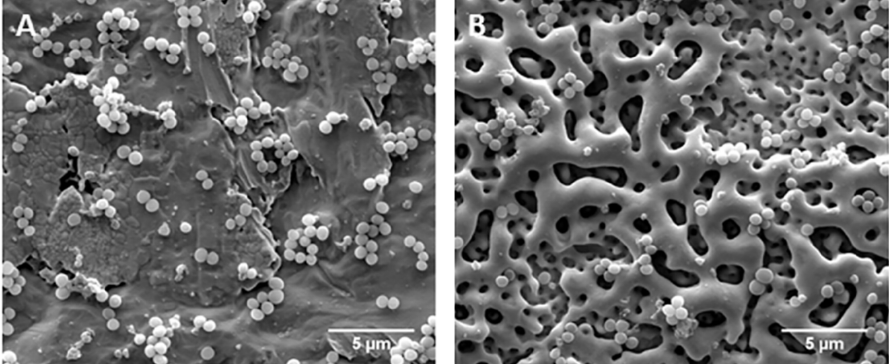
Figure 21. Top view SEM micrographs of S. aureus population after 24 h of incubation on ( A ) untreated Ta and ( B ) MAO-treated Ta surfaces. Adapted with permission from Ref. [74]. Copyright 2021 Elsevier.